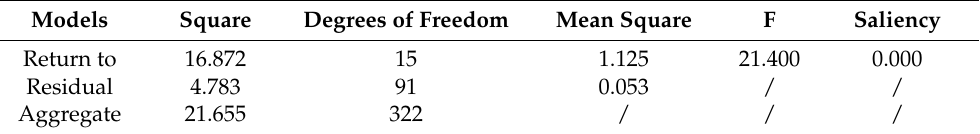
Table 5. Analysis of Variance Table.